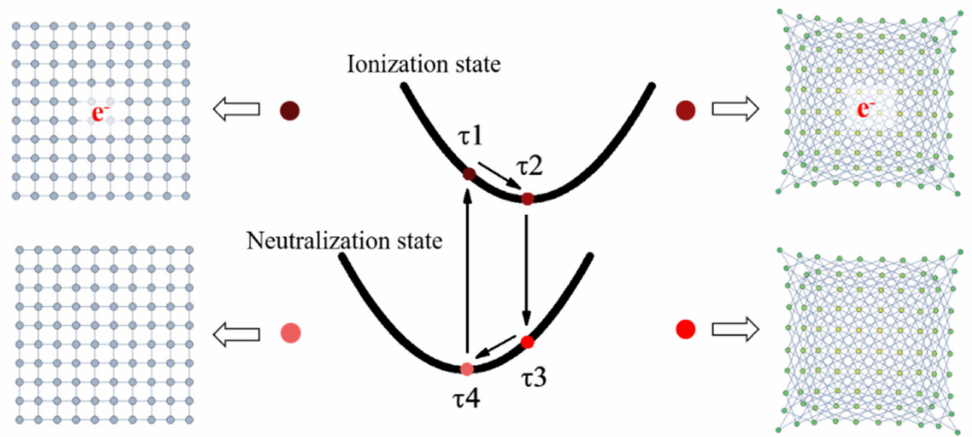
Figure 1. The configuration coordinate for the electron transfer process. τ 1 relates to the ionization of a site in which the phonon is adiabatic without lattice deformation; τ 2 relates to the relaxation of the charged site with the lattice deformation process for a new equilibrium state; τ 3 relates to the neutralization of the charged site in which the phonon is adiabatic, and lattice deformation remains; τ 4 relates to the release of the deformation of the lattice.